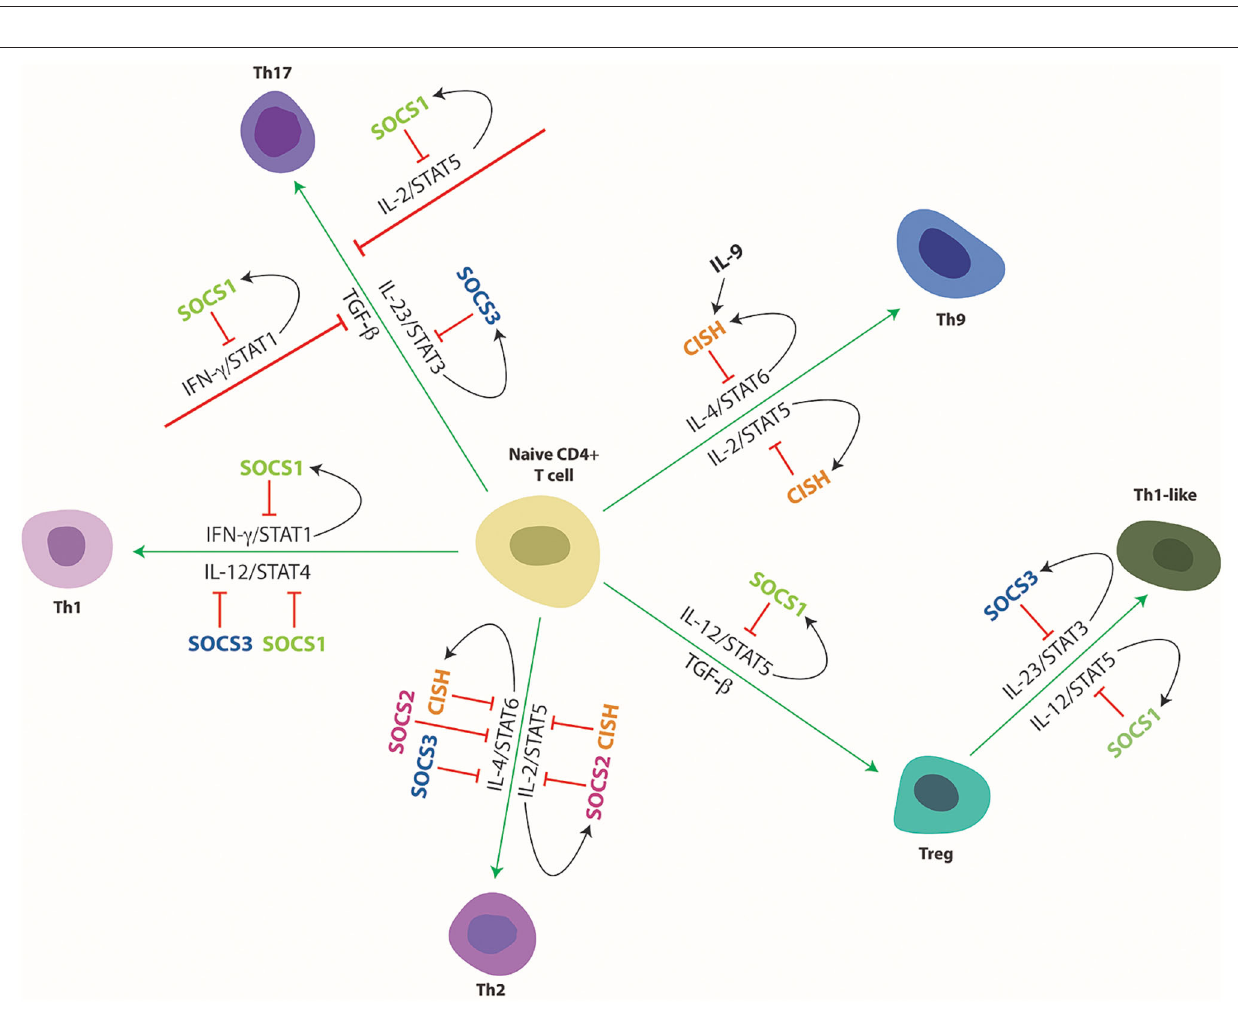
FIGURE 4 | Cytokine mediated differentiation of naïve CD4 + T cells to their various subsets and its regulation by SOCS proteins. Schematic representation of naïve CD4 + T cell differentiation toward the indicated subtypes and its control by specific cytokines and downstream STAT proteins and their regulation by specific SOCS proteins. Green arrows indicate stimulation and red lines indicate suppression of developmental pathways, with black arrows delineating SOCS